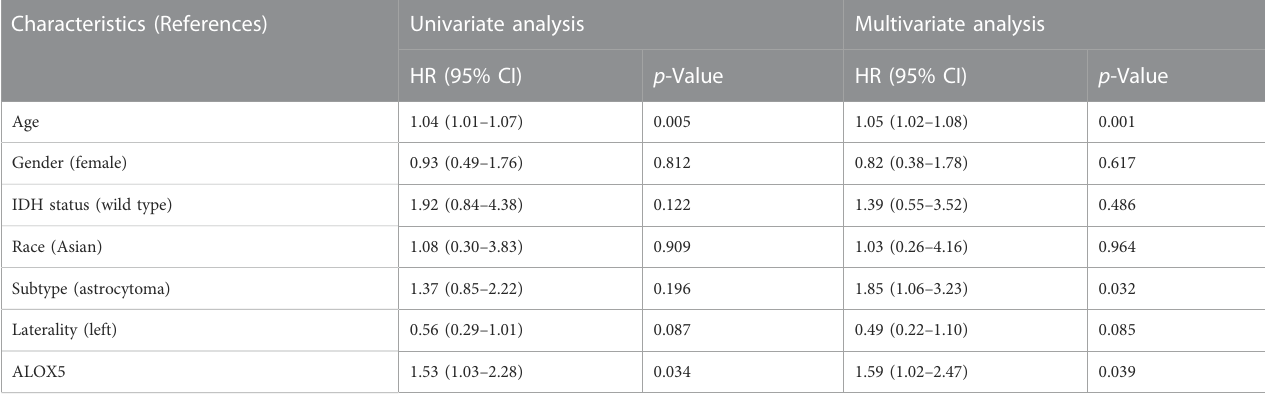
TABLE 2 Cox regression analysis of the association of ALOX5 and clinical variables with DSS in the TCGA-LGG